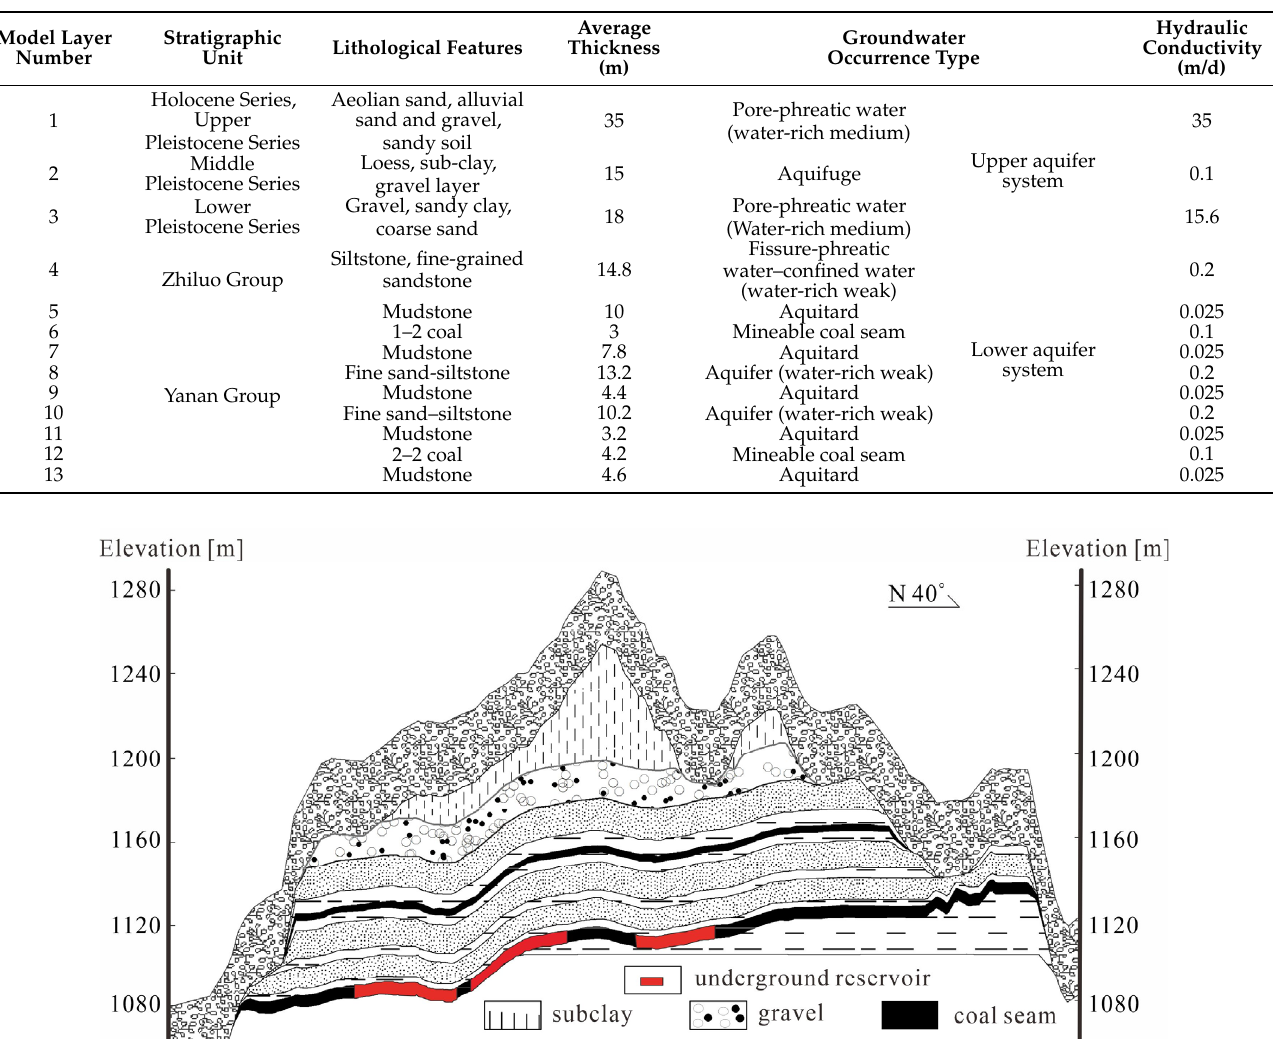
Table 1. Model hierarchy.